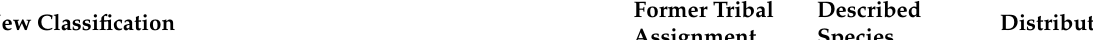
Table A1. General overview of Tachyporinae sensu nov. under the new